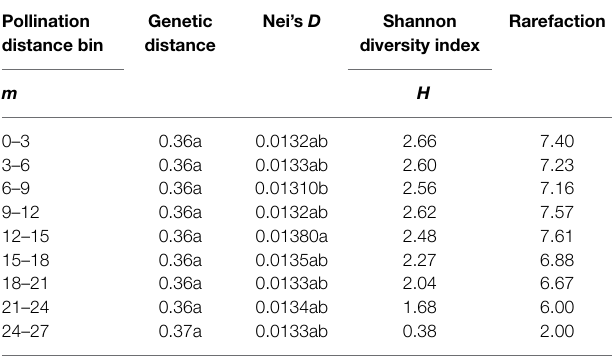
TABLE 2 | Diversity indices in the progeny population as a function of pollination distance